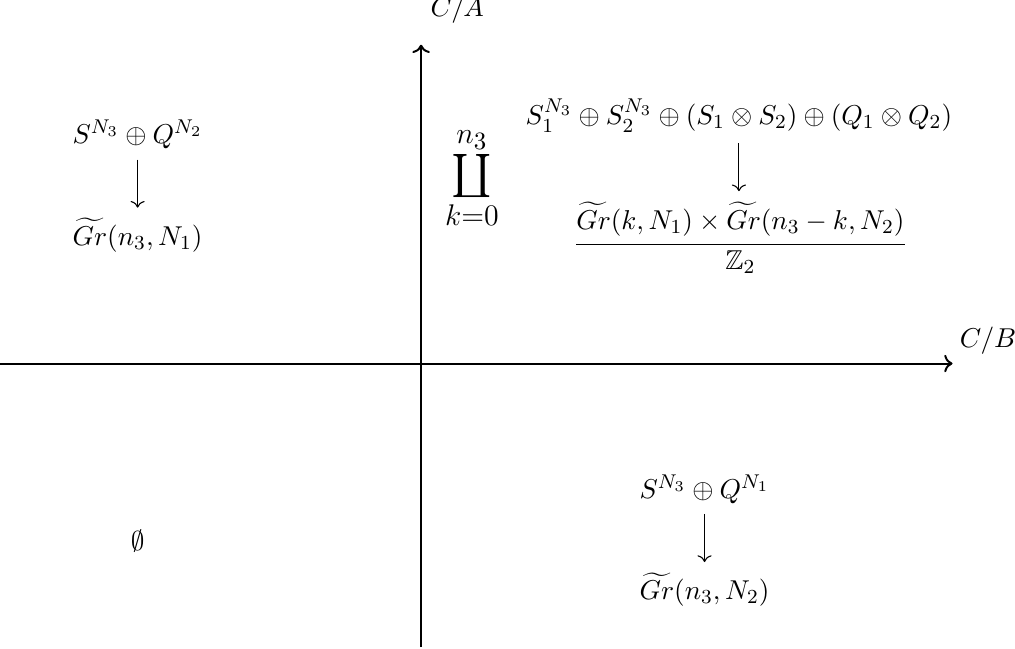
Figure 2 . The classical phase diagram for the family of SO( n 3 ) gauge theories. Globally, the space of couplings ( A; B; C ) modulo rescalings is RP 2